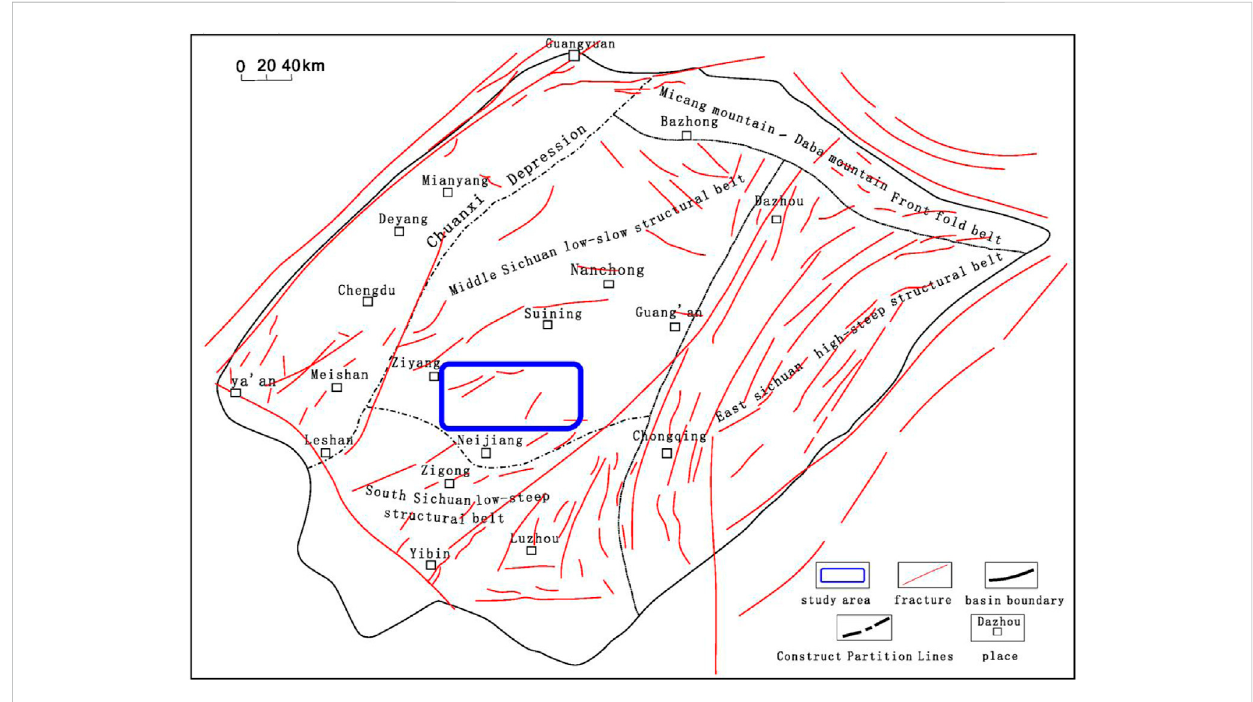
FIGURE 1 Structure location map of WY shale gas fi